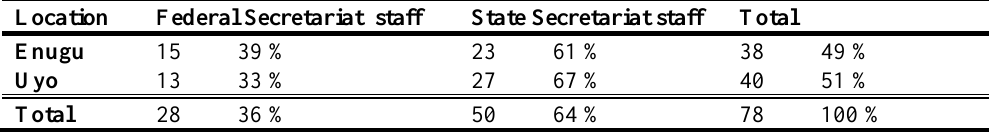
Table 3. Returned Questionnaires by the Respondents (developed by the authors)